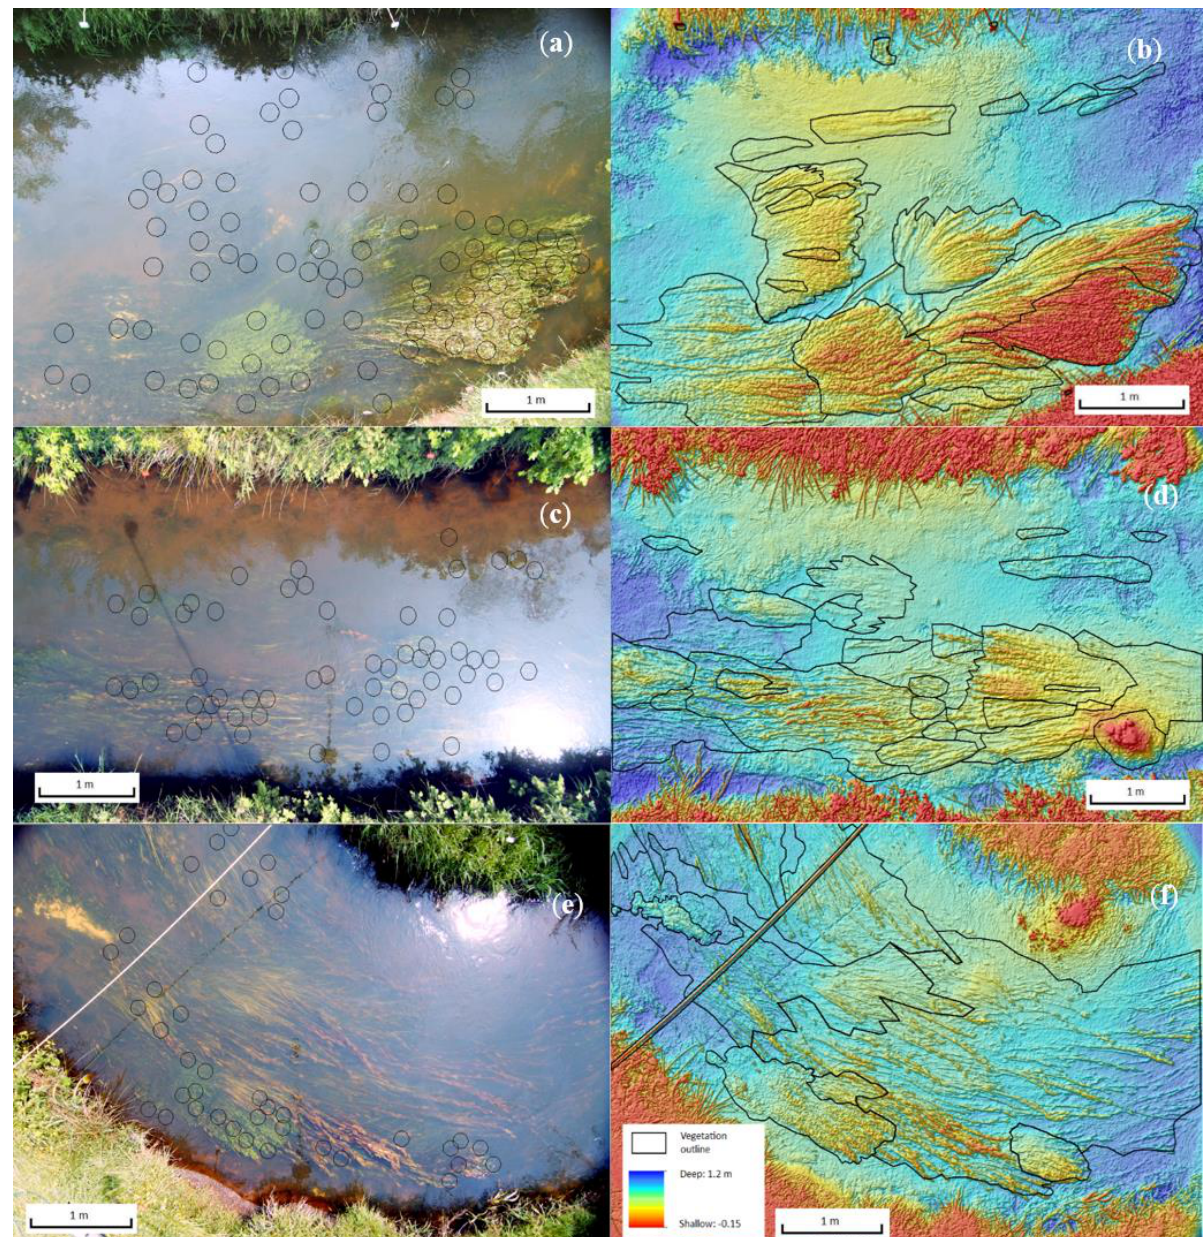
Figure 9. RGB composite of site 1b ( a ); DEM of site 1b based on NIR(R72) ratio-model ( b ); RGB composite and DEM based on NIR(R72)-model for site 2 ( c , d ); RGB composite and DEM based on NIR(R72)-model for site 3 ( e , f ). All DEMs have been smoothed with a 5 × 5 filter. Hillshade is added to enhance the visibility of the relief. Black lines